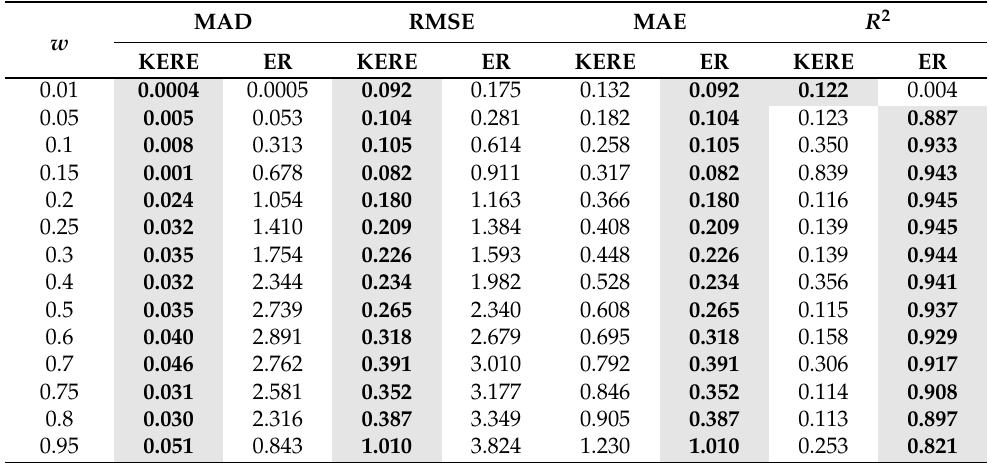
Table 7. Indirect emissions. The testing MAD, RMSE, and MAE metrics for both KERE and ER are reported with respect to the various expectile levels ranging between 0.01 and 0.99. MAD RMSE w